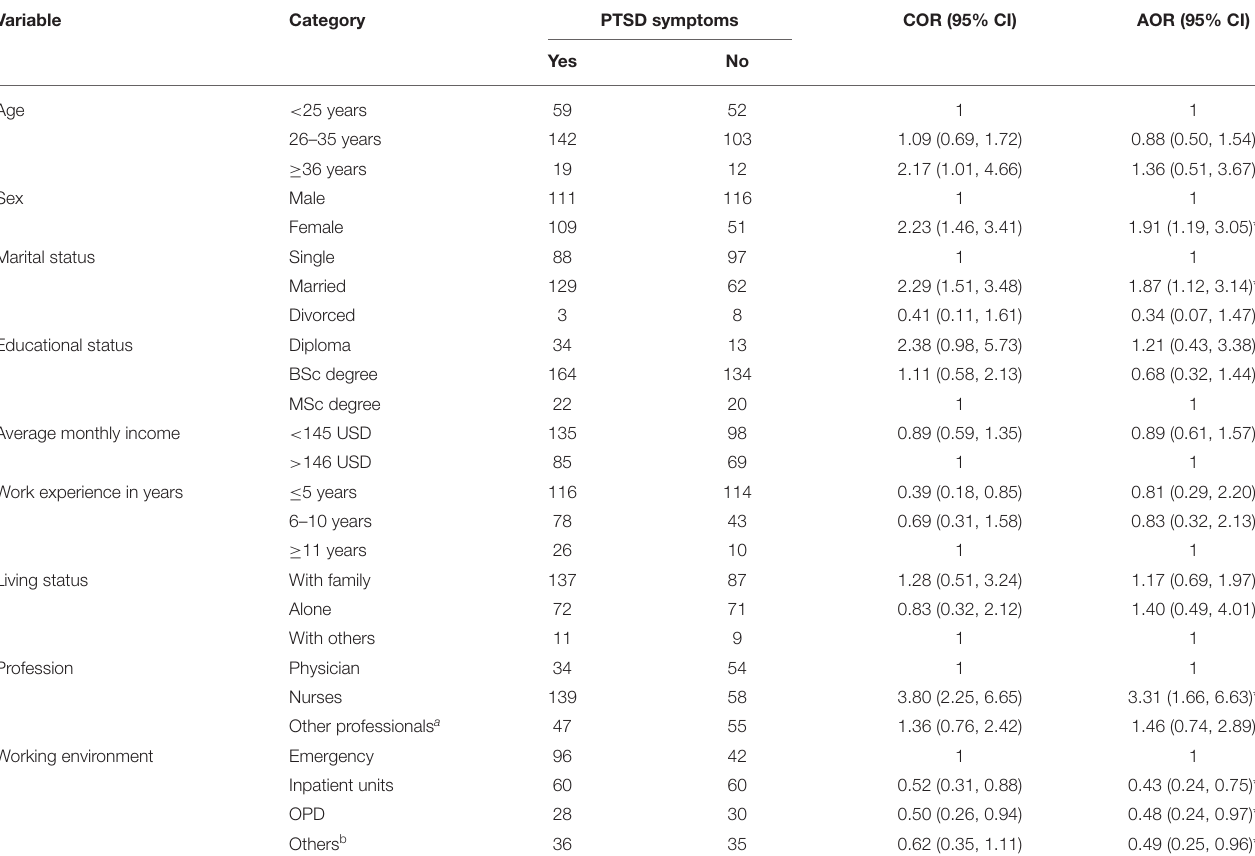
TABLE 2 | Factors associated with PTSD symptoms of the study participants during COVID-19 pandemic in selected hospitals of Sidama National Regional State, southern Ethiopia, 2020 ( n = 387).